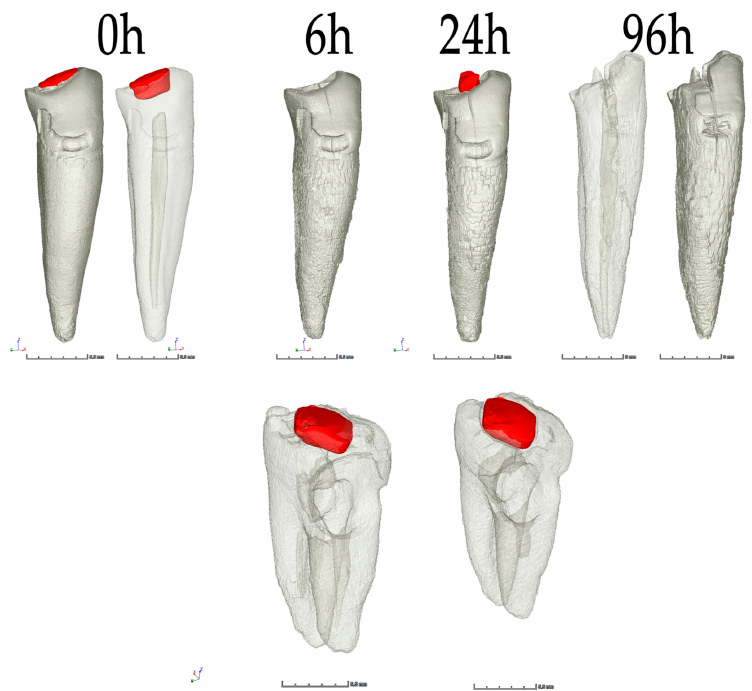
Figure A1. Digital visualization of sample micro-CT segmentations. From top row: (1—the first row) Sample 32 intact tooth; (2) sample 38 with untreated caries; (3) sample 43 with glass-ionomer cement; (4—the last row) sample 47 with amalgam.